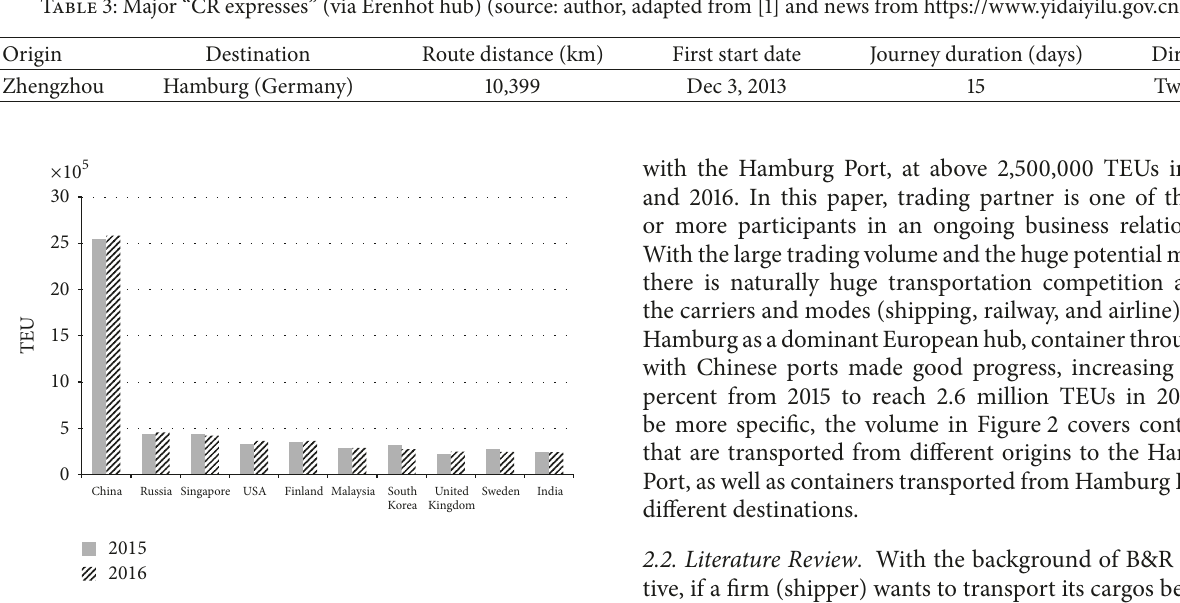
Figure 2: Top 10 trading partners in seaborne container traffic of Hamburg Port (source: author, adapted from https://www.hafen-